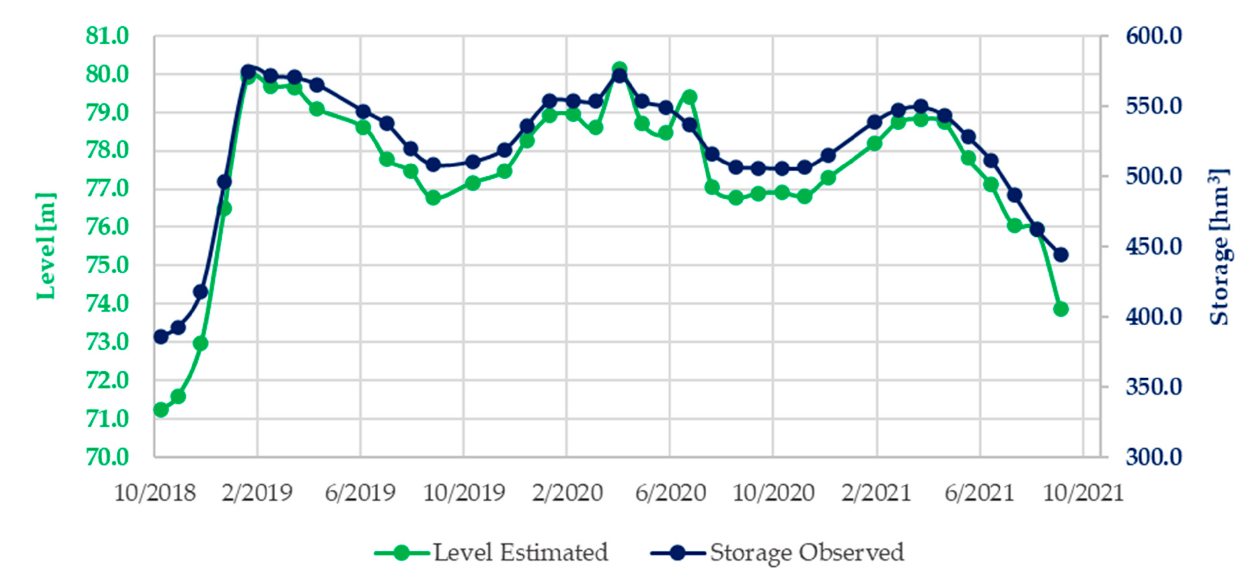
Figure 7. Sentinel-3-derived Yliki reservoir water level and observed storage time series.